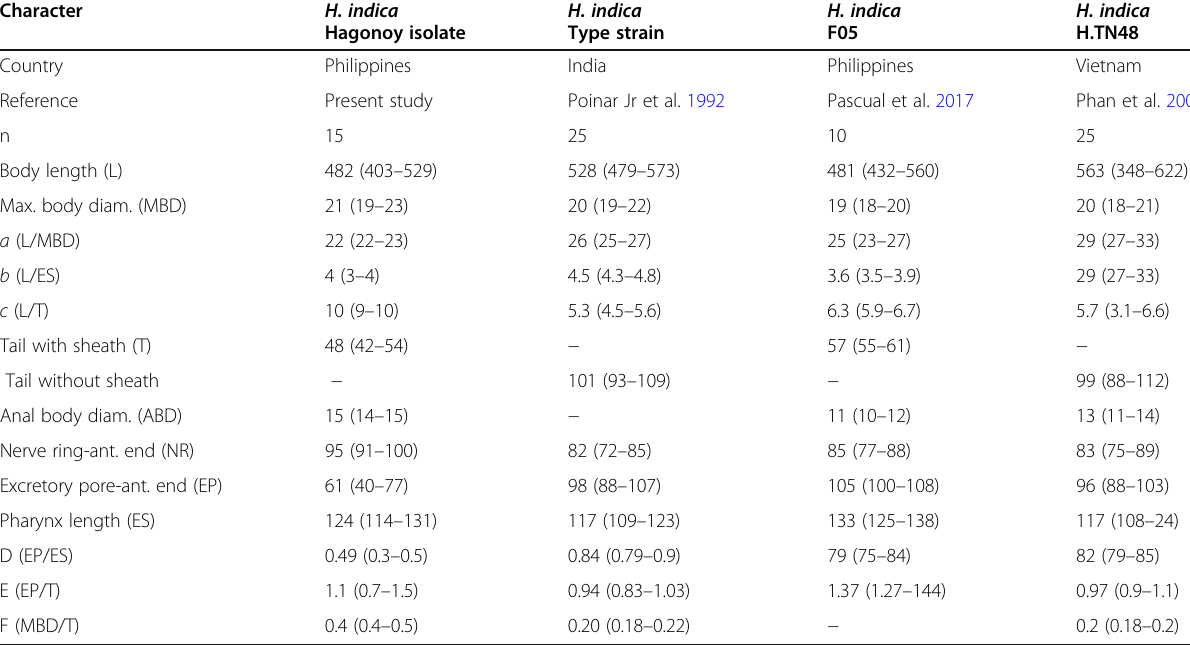
Table 2 Compendium of infective juveniles of Heterorhabditis indica Hagonoy isolate (HBP1) with the type strain and other populations. All morphometric measurements are in micrometres (except n , ratio and percentage) and expressed as means